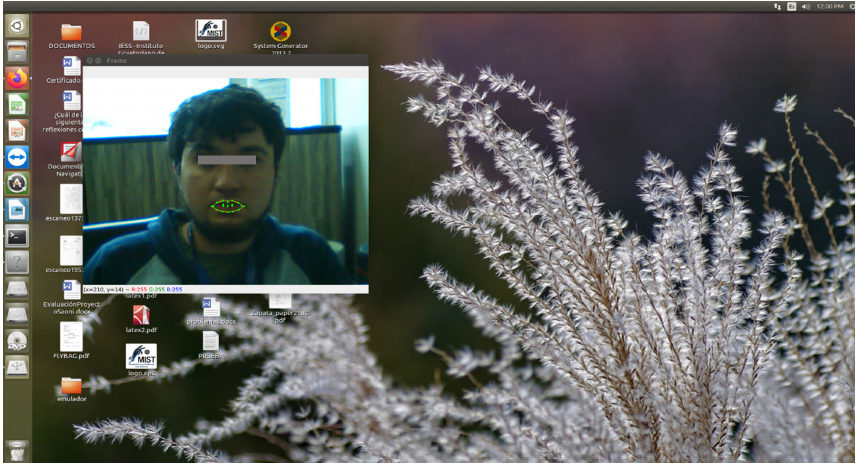
Figure 11. EMKEY running on